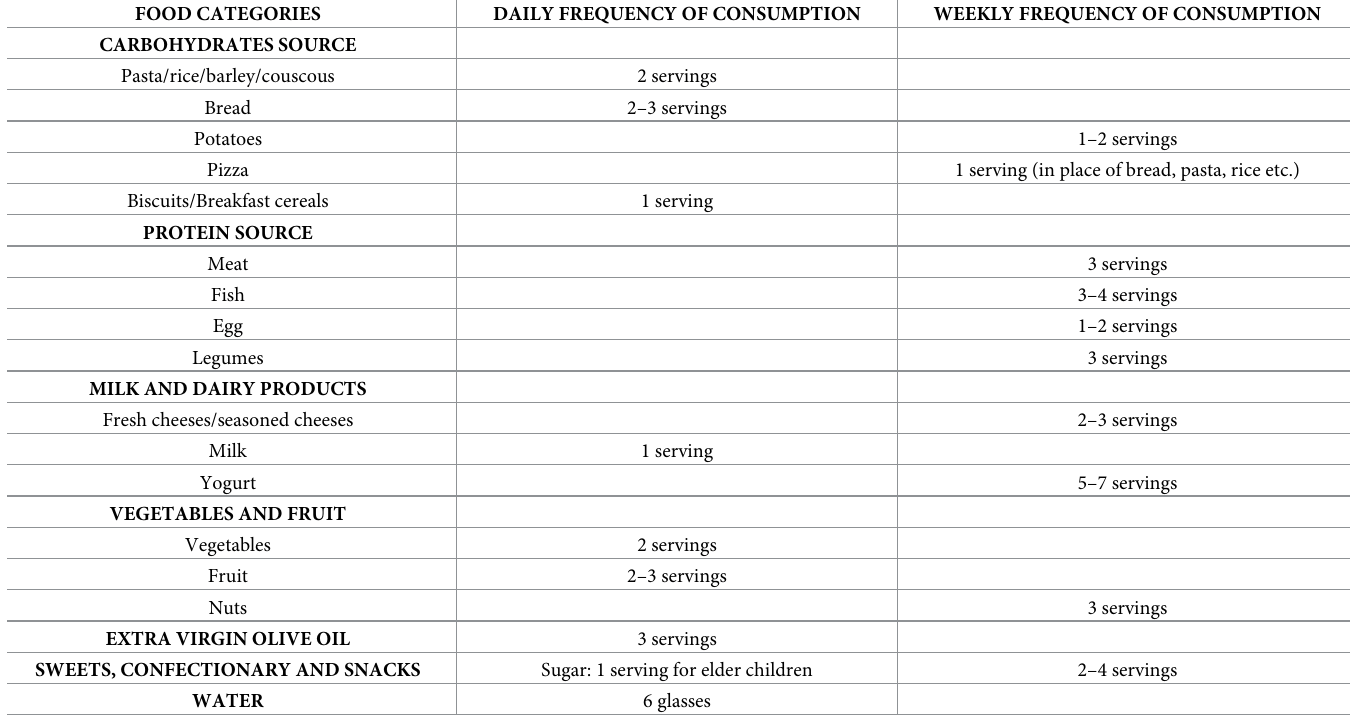
Table 2. Frequencies of consumption. Daily and weekly frequencies of consumption of some foods according to